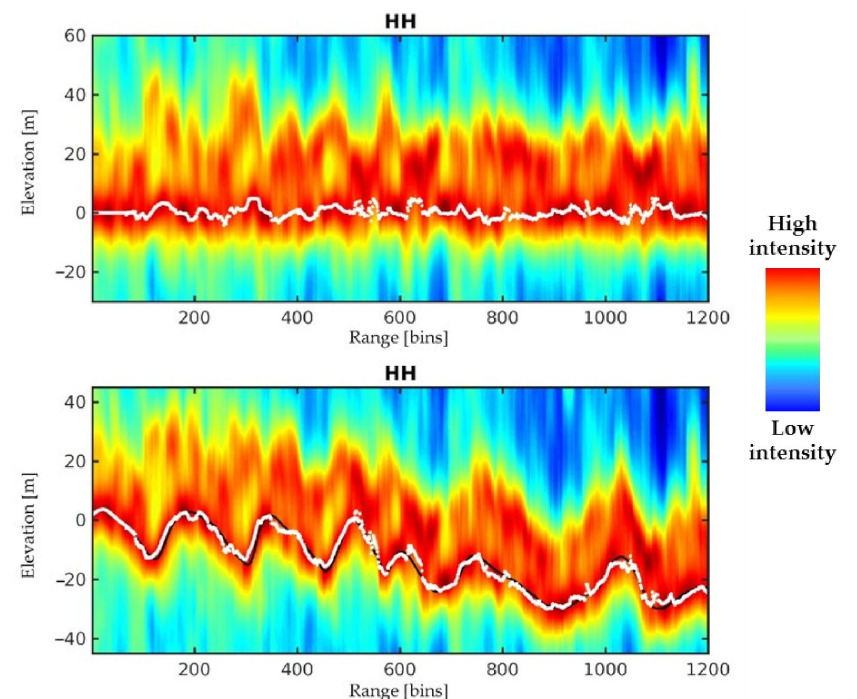
Figure 5. Tomographic intensity profiles estimated in the range direction, in absolute coordinates (top) and after compensation of the lidar DTM estimate (bottom). Horizontal coordinates run from near range (left) to far range (right). The lidar profile is plotted as a black continuous line, and the tomographic estimates are represented with a white dotted